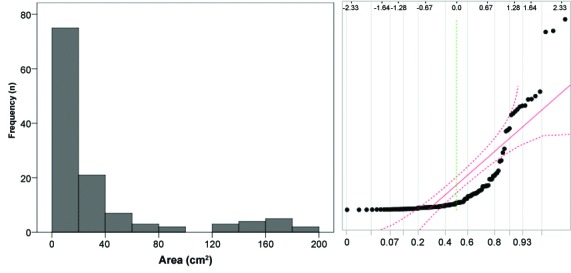
Venous ulcers (n = 125) in patients treated at the Dermatology Service, Faculdade de Medicina de Botucatu, Universidade Estadual Paulista (UNESP), SP, Brazil: histogram and Q-Q plot for areas in cm2.